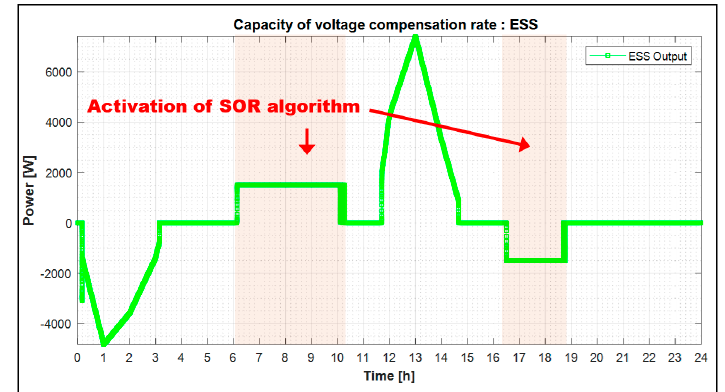
Figure 23. Operation signal of the SOR algorithm.